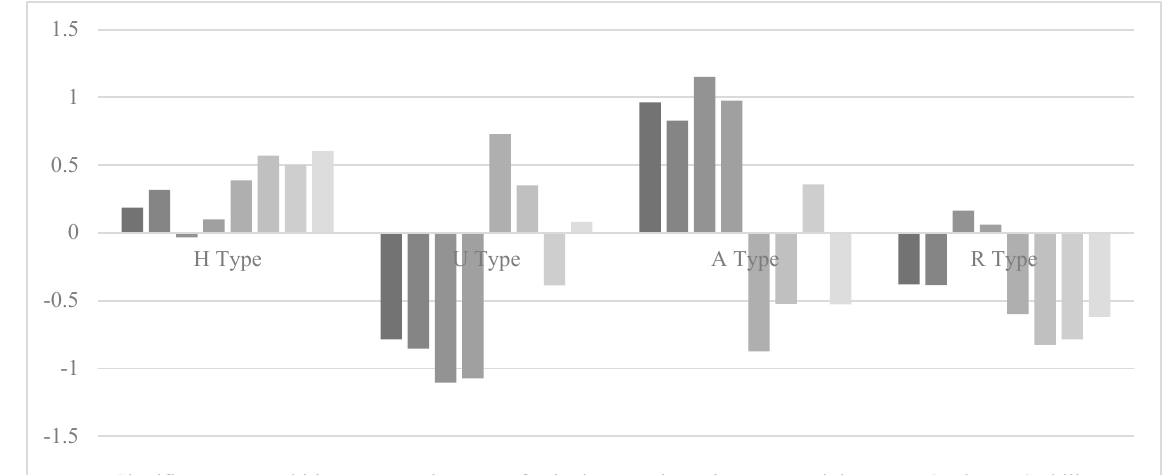
Figure 1. Z-scores for subscales of engagement and resilience by self-regulatory patterns. H = healthy-ambitious type; U = unambitious type; A = excessively ambitious type; R = resigned type.